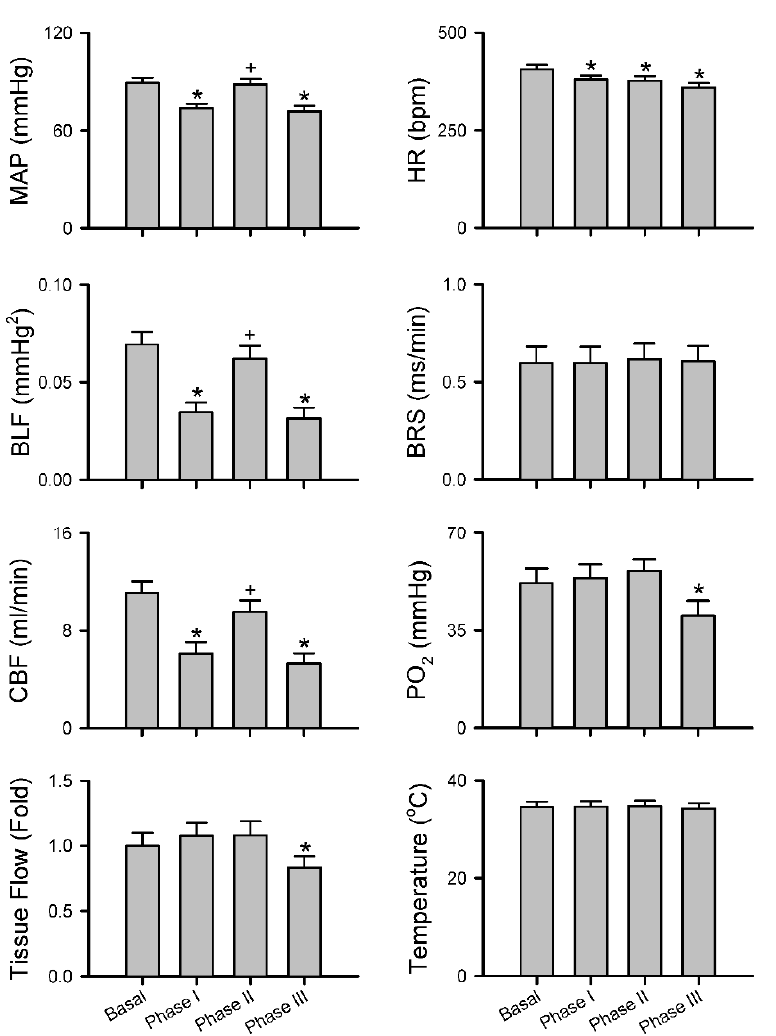
Figure 8. Anomalous response patterns of MAP, HR, BLF, BRS and CBF or tissue perfusion, PO 2 or temperature in the cerebral cortex to intrathecal administration of 80 µ L of bupivacaine. Note that values for MAP, HR, BLF and BRS are mean ± SEM of 15 animals (7 from Group 2 plus 8 from Group 3); values for CBF are mean ± SEM of 7 animals from Group 2; and values for tissue perfusion, PO 2 or temperature in the cerebral cortex are mean ± SEM of 8 animals from Group 3. * p < 0.05 versus data obtained under basal conditions in the post hoc Dunnett multiple-range analysis; + p < 0.05 versus data obtained during Phase I in the post hoc Tukey multiple-range analysis.